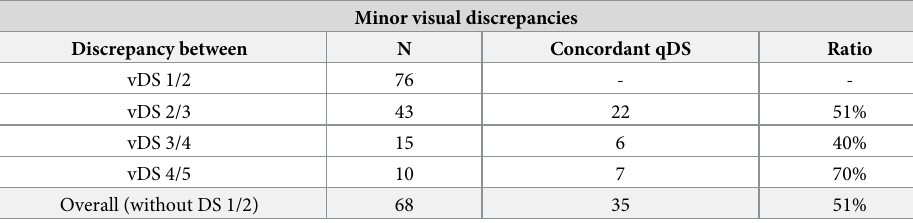
Table 3. Comparison of the quantitative Deauville score (qDS) in minor visual